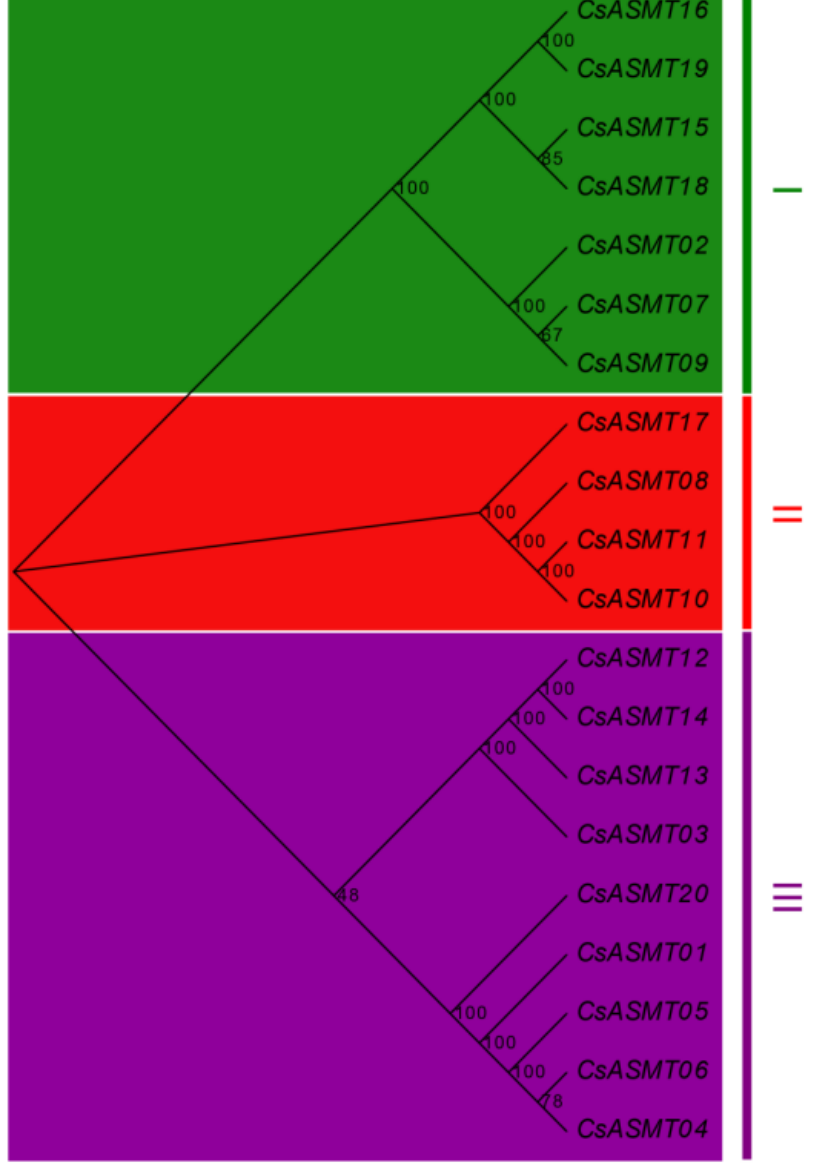
Figure 1. Phylogenetic analysis of ASMT genes in C. sinensis. The phylogenetic tree was constructed based on the sequences of CsASMT proteins using the neighbor-joining method with bootstrap analysis (1000 replicates) in MEGA X.